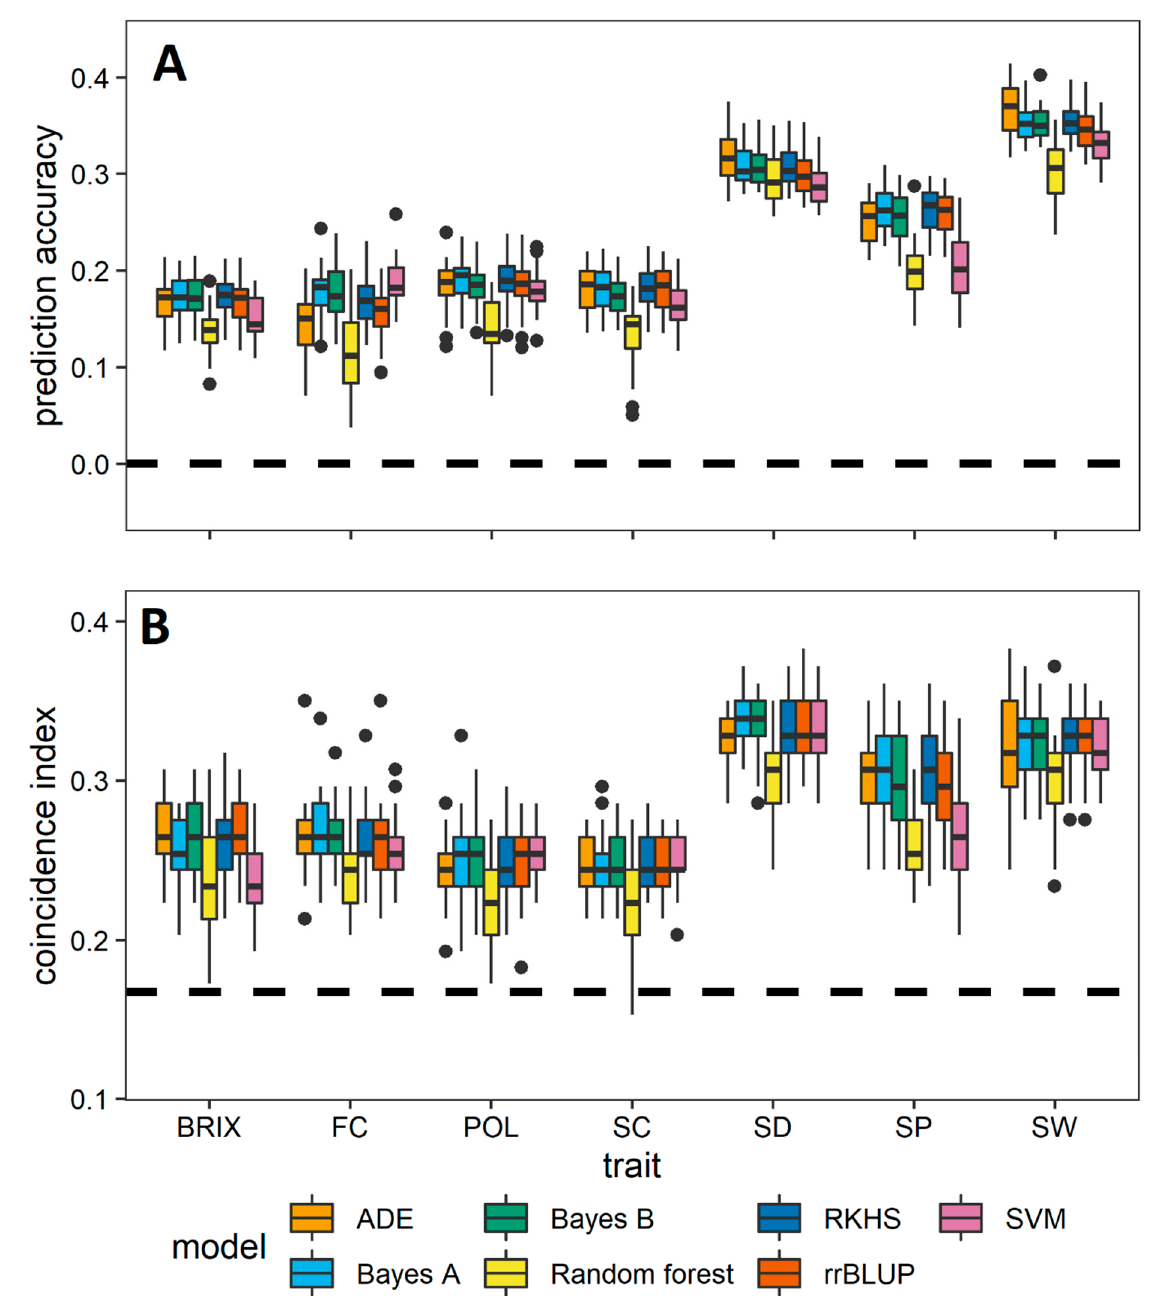
Figure 1. Prediction accuracy ( A ) and coincidence index ( B ) of the genomic estimated breeding estimated value (GEBV) of seven yield- and sugar-related traits for fivefold cross-validation (fivefold CV) of seven genomic selection (GS) methods. The fivefold CV was performed by randomly selecting four-fifths of the individuals for training and reaming a fifth as the validation population for the plant cane. The seven traits were Brix, fiber content (FC), pol, sucrose content (SC), stalk diameter (SD), stalk population (SP), and stalk weight (SW).